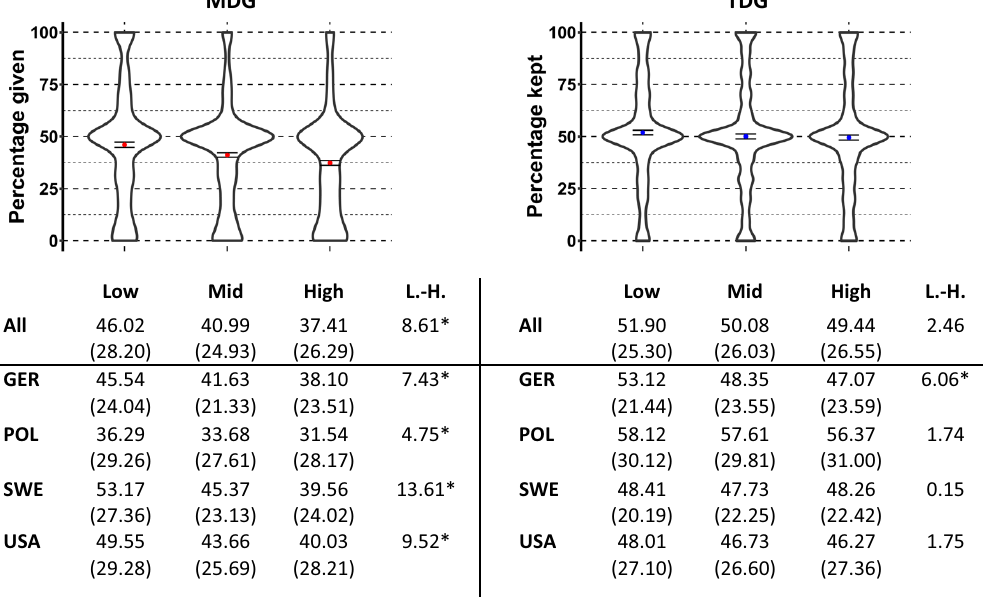
Figure 2. The redistribution across SES groups is more heterogenous in the MDG than in the TDG. Shown are violin plots of percentages given (MDG, y-axis left) and kept (TDG, y-axis right) with mean value and 95% confidence interval per SES of recipients (low, mid, high) in the MDG and TDG across all countries (pooled model), as well as mean values and standard deviations of percentages given (MDG) and kept (TDG) and the difference in mean values between low- and high-status recipients (L.-H.) for all countries and separately for each country (Germany, Poland, Sweden, USA); * denotes significant differences at least at the 5% level based on a two-tailed t-test for country models and bivariate regressions with cluster-robust standard errors for pooled models (see also Table S3, suppl.